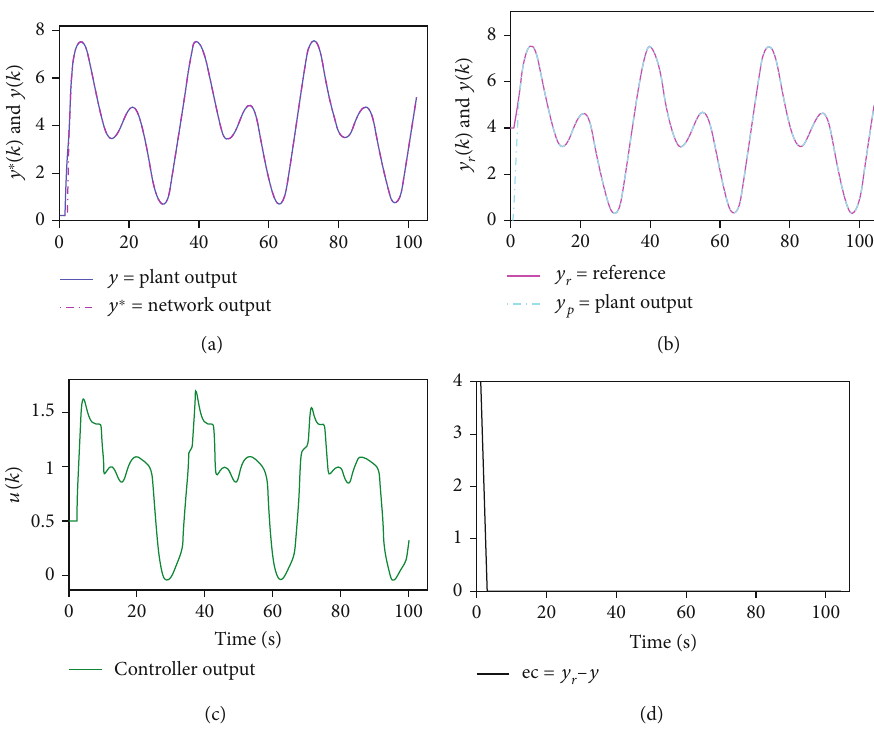
Figure 9: Example 2: (a) response of an ANN-NARX identi fi cation model, (b) response of the plant under the NARX controller, (c) NARX controller output, and (d) control error with the NARX model (using n = 3 and m = 2 ).